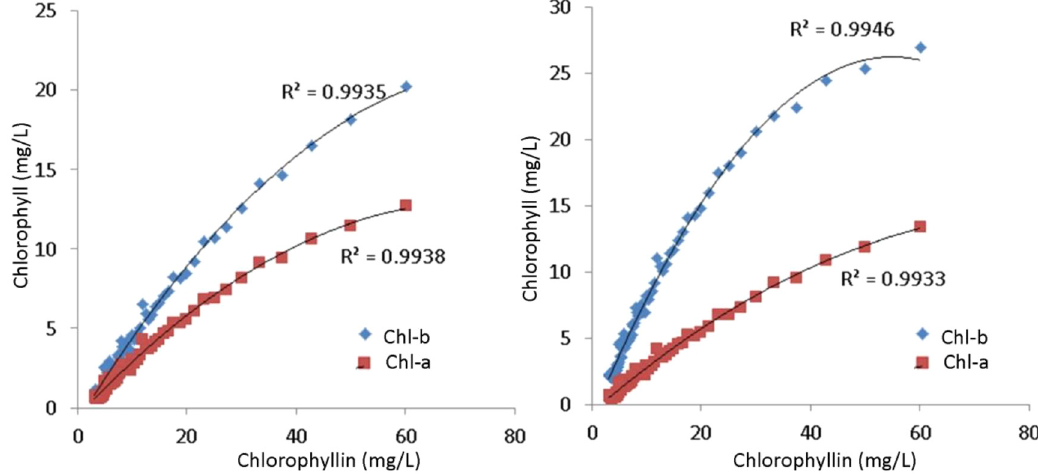
Fig. 3. Relationship of different types of chlorophyll (a and b) in chlorophyllin using different methods of chlorophyll determination; Lichtenthaler (left) and Arnon (right).